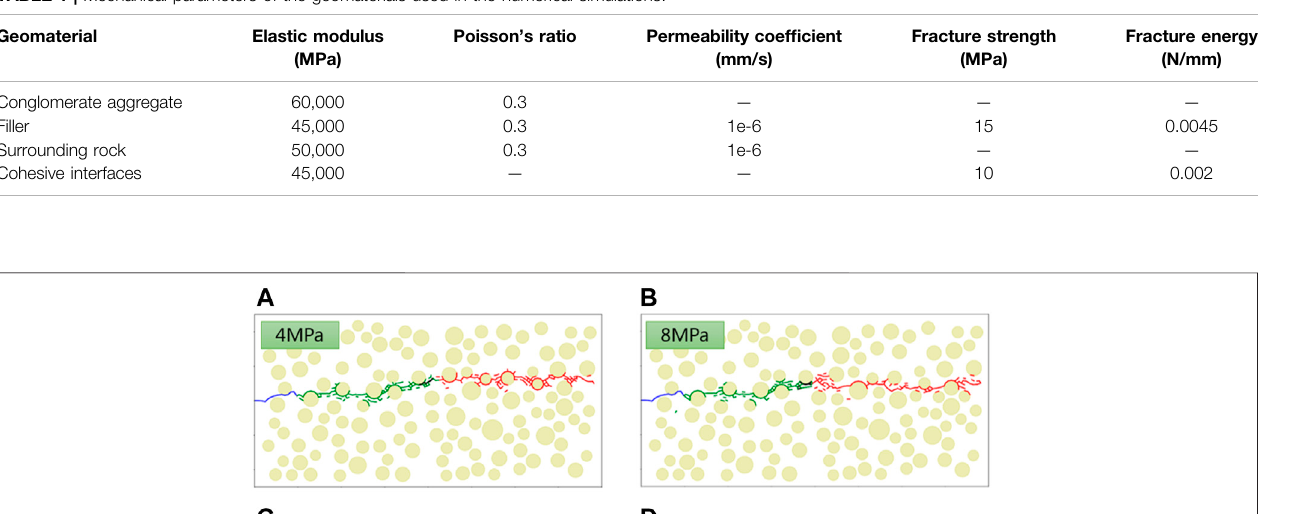
Frontiers in Physics |